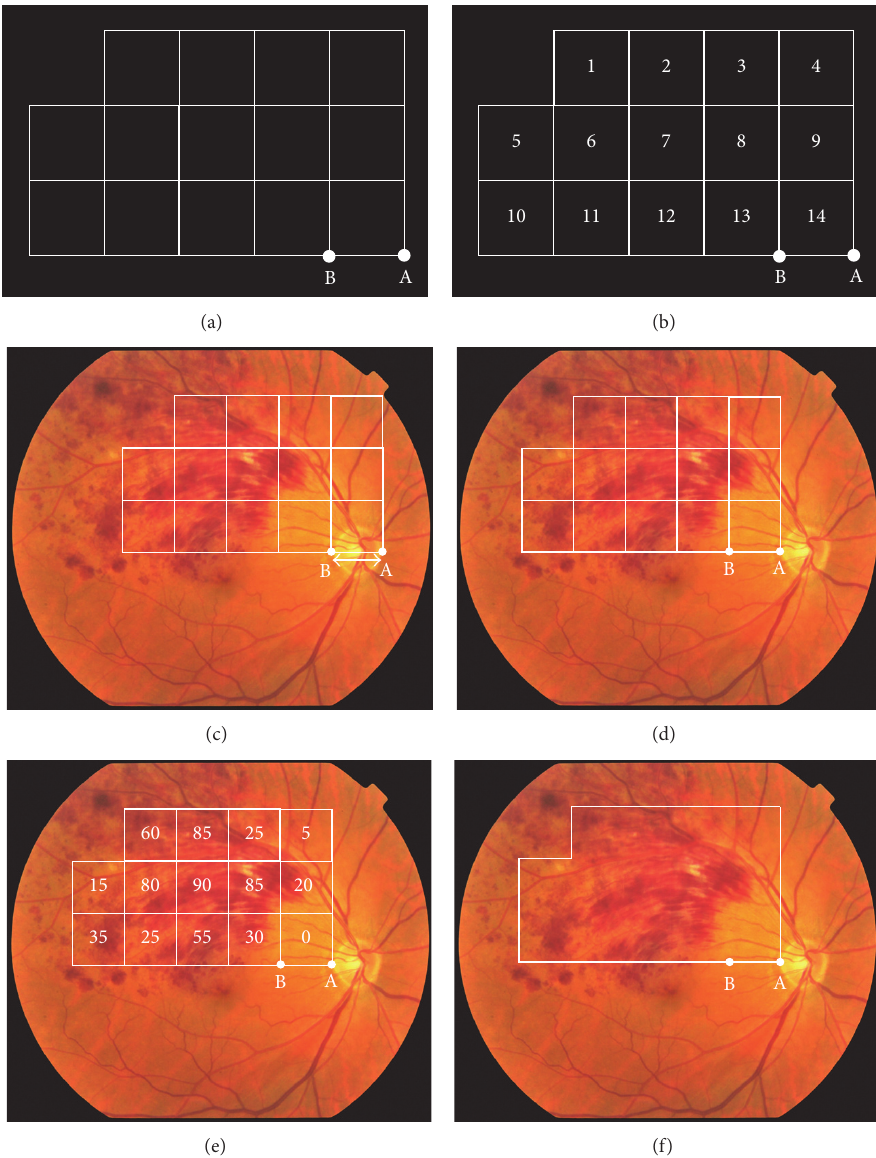
Figure 1: Method of determining the area occupied by a retinal hemorrhage in a fundus photograph using a grid with 14 squares. First, a grid with 14 squares (a) is created by the PowerPoint (PPT) software (a). Each square is numbered starting at the top left (b). Next, a fundus photograph of BRVO was downloaded into a PPT file, and the grid with 14 squares was laid over the fundus photograph. The grid was enlarged or reduced so that one side of a square grid (the length of the line BA) would match the horizontal diameter of the optic disc (c). Then, the point A on the grid was placed at the temporal edge of the optic disc (d). Then, retina specialists (raters) visually estimated what percent of the area of each of the 14 squares was occupied by the retinal hemorrhage. This relative size ranged from 0 to 100% in increments of 5% (e). The total was averaged to yield the size of the hemorrhage as a percent of the entire grid. To determine the effectiveness of using the grid, an empty box of the same size as the grid was created (f), and this box was laid over a fundus photograph in the same